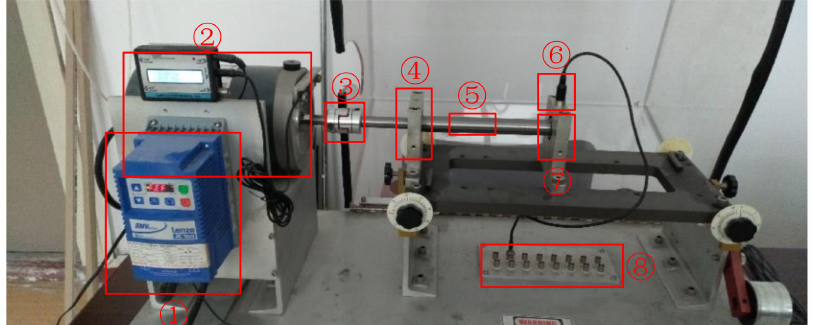
Figure 12. The self-made bearing fault platform. 1 (cid:13) motor driver, 2 (cid:13) three-phase AC motor, 3 (cid:13) coupler, 4 (cid:13) healthy bearing and its foundation, 5 (cid:13) rotating shaft, 6 (cid:13) acceleration sensor, 7 (cid:13) fault bearing and its foundation, 8 (cid:13) signal collection